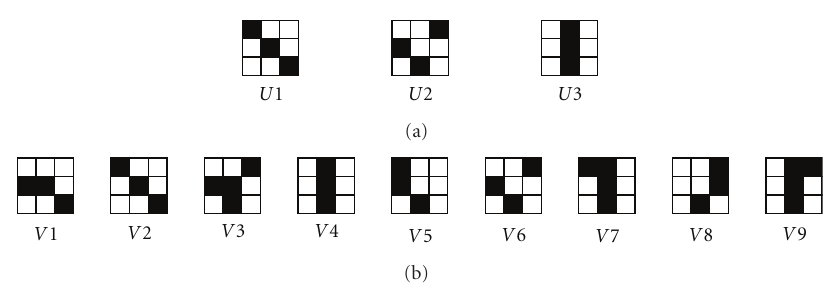
Figure 6: (a) the input patterns Ui (up). (b) template patterns Vi (down).